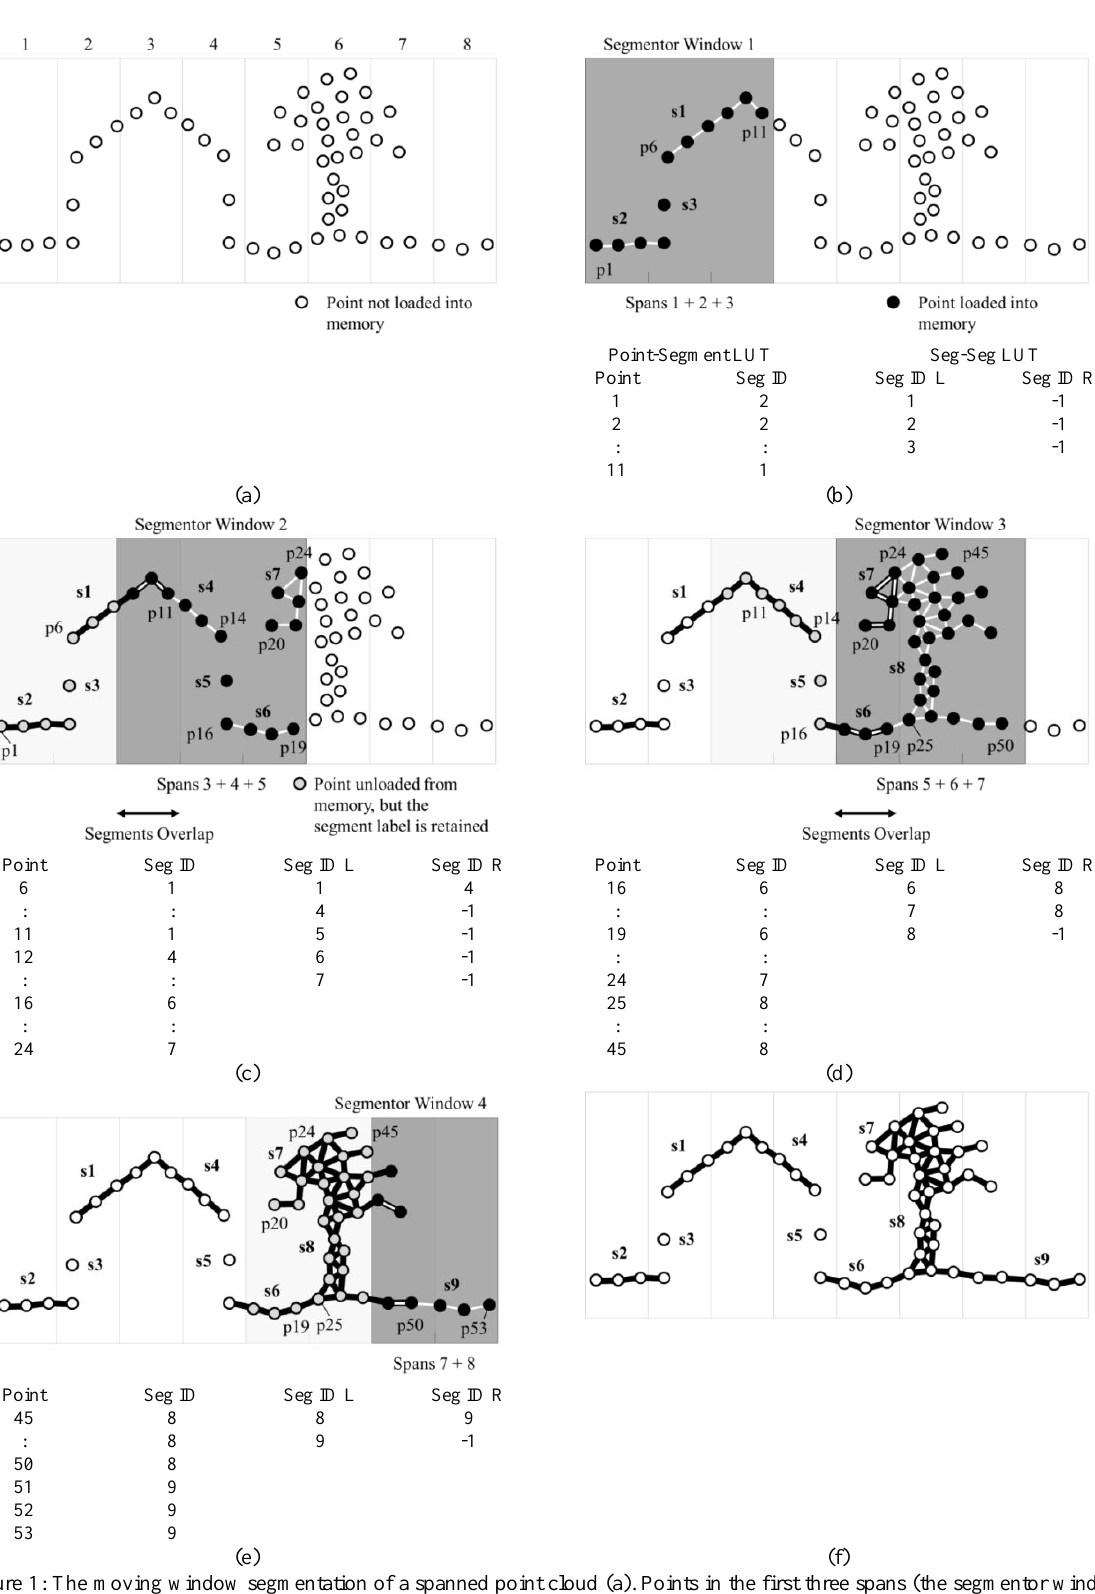
Figure 1: The moving window segmentation of a spanned point cloud (a). Points in the first three spans (the segmentor window) are selected and segmented (b). The segmentor window is moved forward by two spans. There is an overlap of one span